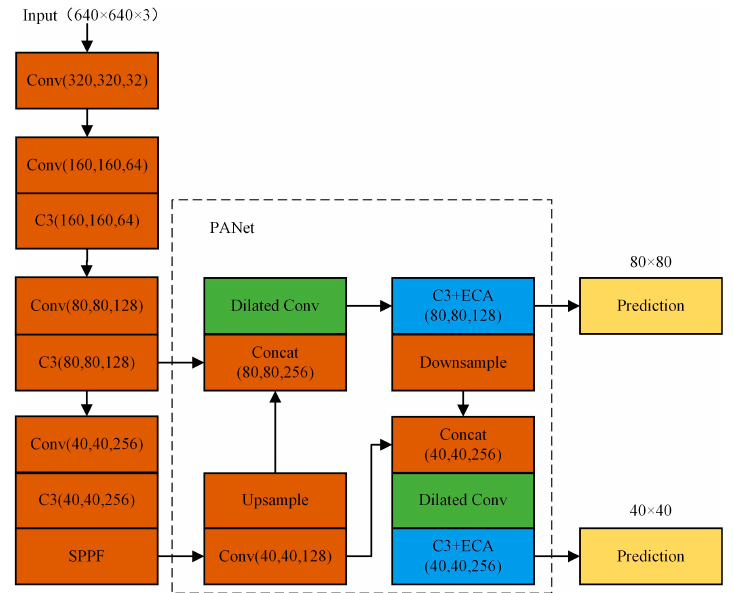
Figure 6. Proposed YOLOv5-QCB structure in this